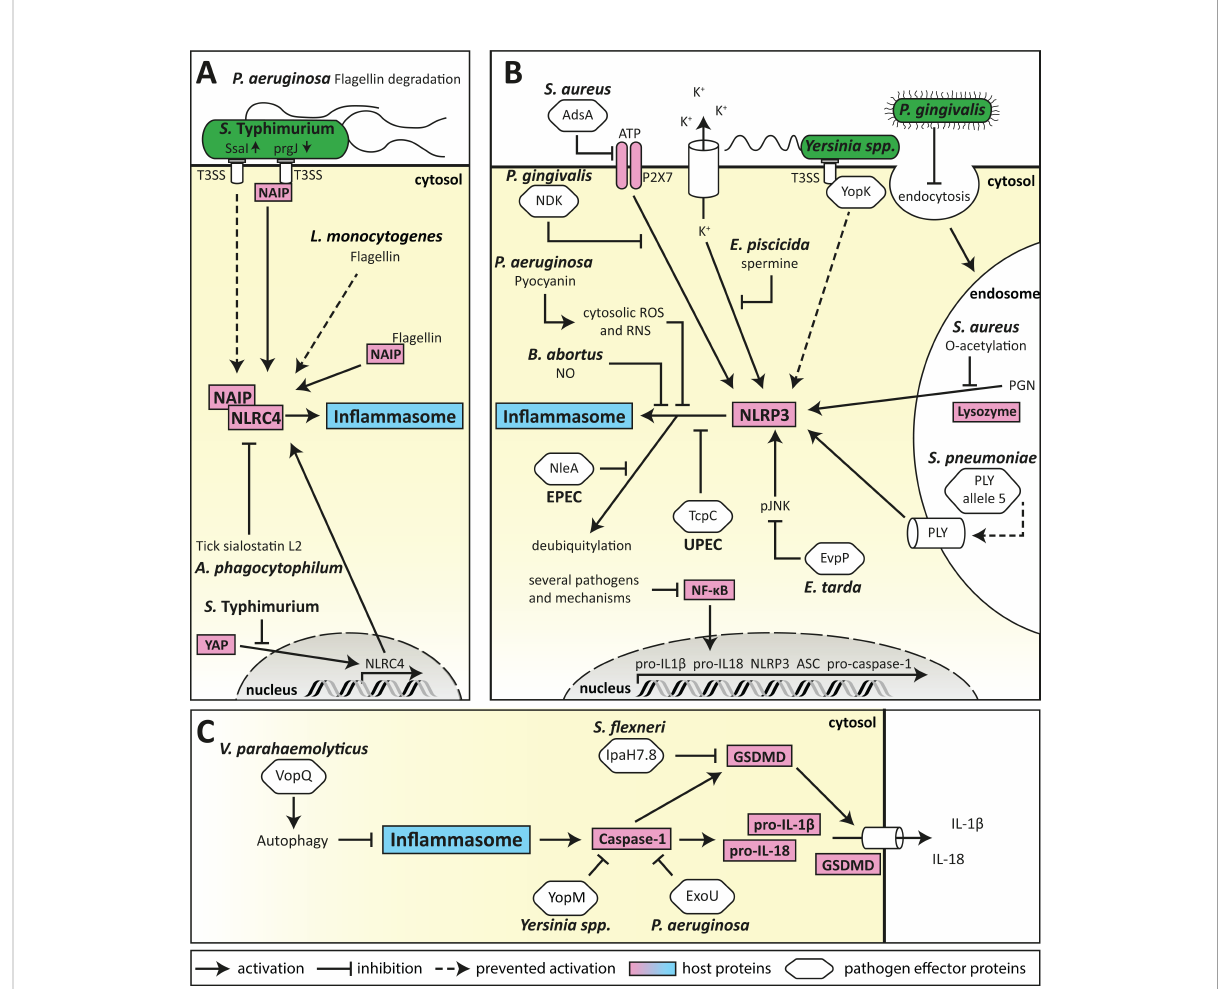
FIGURE 2 Mechanism of bacterial evasion of in fl ammasome activation and signalling. (A) Bacterial evasion of the NLRC4 in fl ammasome. Evasion of NAIP detection is one of the major subversion strategies for bacteria recognised by the NLRC4 in fl ammasome. This can be performed by the expression of poorly immunogenic S. Typhimurium T3SS rod proteins, or L. monocytogenes fl agellin, as well as by proteasomal degradation of P. aeruginosa fl agellin. Furthermore, expression of NLRC4 can be suppressed by S. Typhimurium through inhibition of host transcription factors, and by A. phagocytophilum by exploitation of vector-mediated release of anti-in fl ammatory compounds. (B) Bacterial evasion of the NLRP3 in fl ammasome. Subversion of the NLRP3 in fl ammasome can be conferred by several different mechanisms (shown in clockwise order). First, several pathogens can prevent transcription of in fl ammasome components by inhibiting NF- k B signalling. Second, pathogenic bacteria can inhibit activation of the NLRP3 in fl ammasome by DAMPs, such as via the degradation of extracellular ATP by AdsA from S. aureus , inhibition